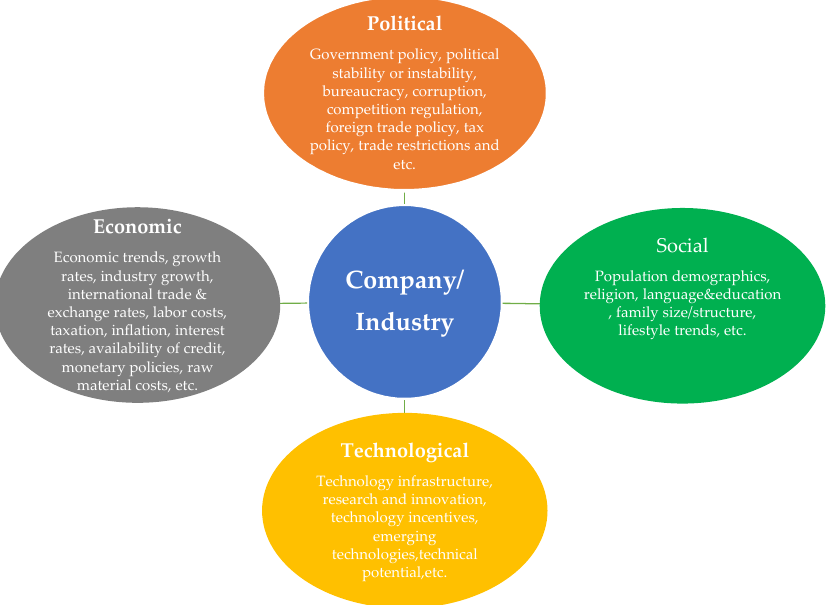
Figure 1. Framework and main contents of PEST analysis. Source: PEST analysis financial definition of PEST analysis (thefreedictionary.com (accessed on 16 May 2021)) .